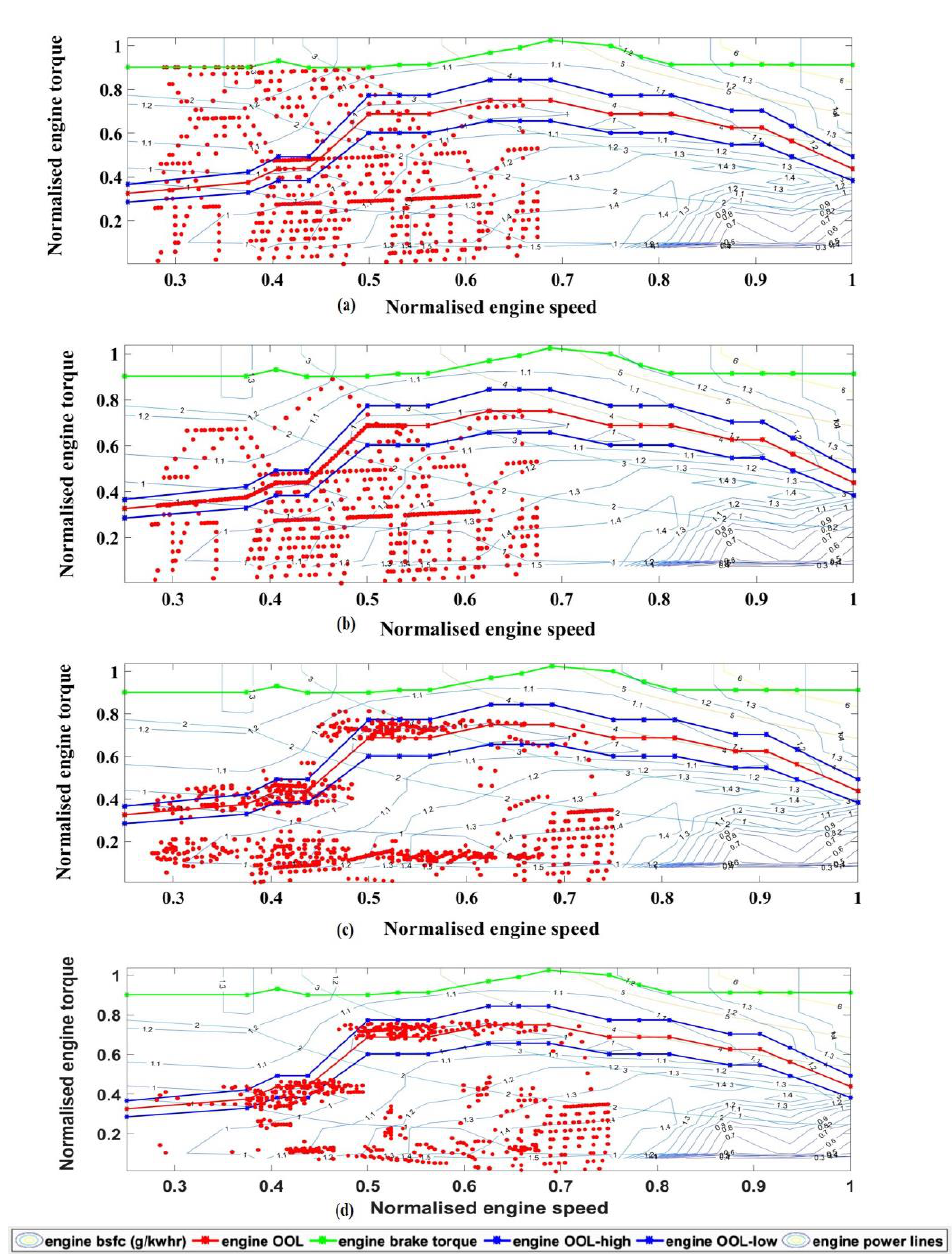
Figure 8. Veh1 engine operating points for different controllers tested for the WMTC test cycle: ( a ) (BEMS), ( b ) MEMS, ( c ) ECMS and ( d ) ECMS_LL.